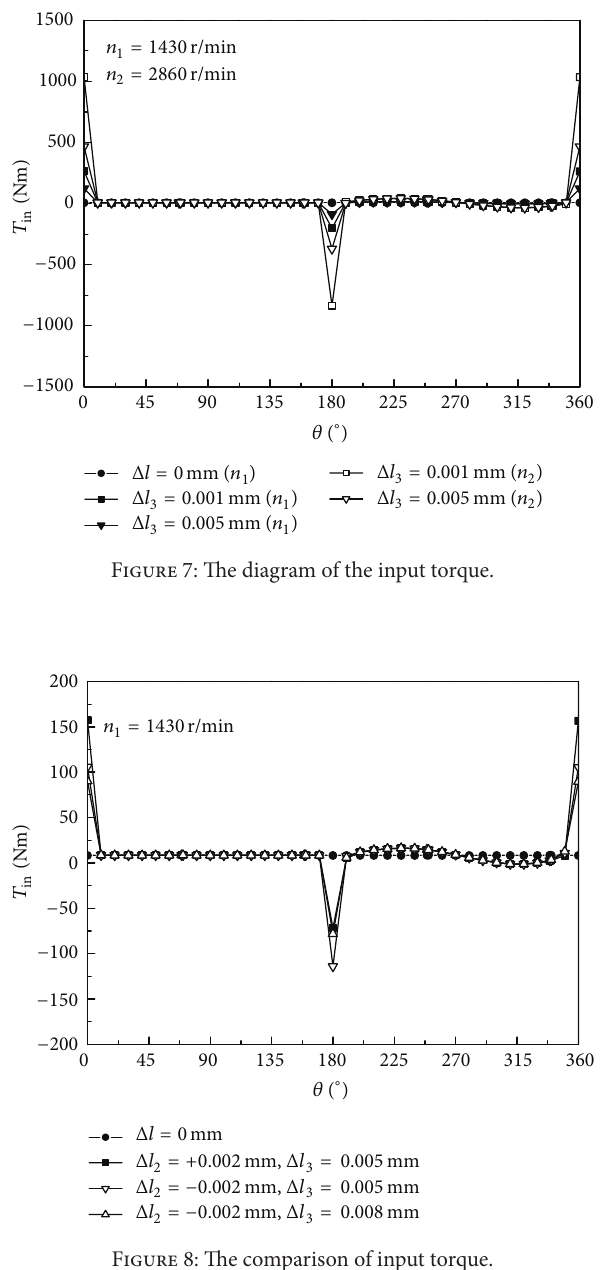
Figure 8: The comparison of input